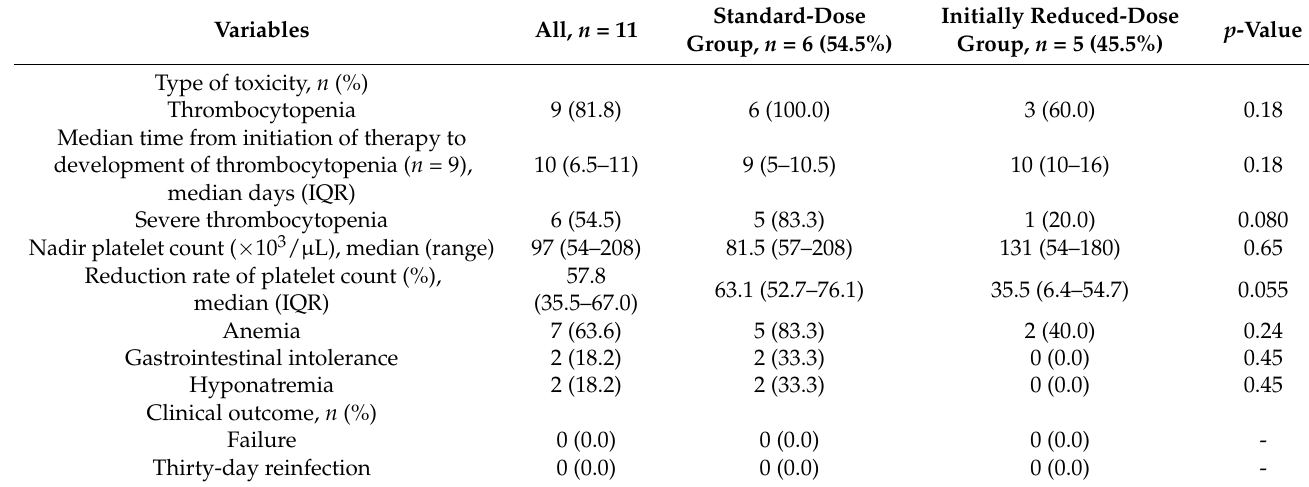
Table 2. Linezolid-related adverse events and clinical outcome in the standard-dose group and initially reduced-dose